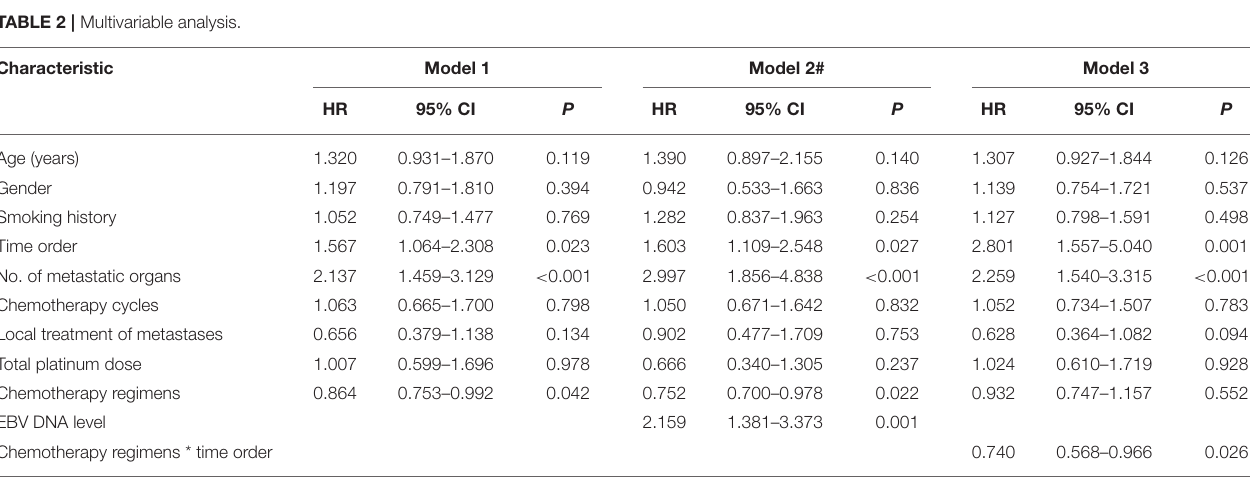
TABLE 2 | Multivariable